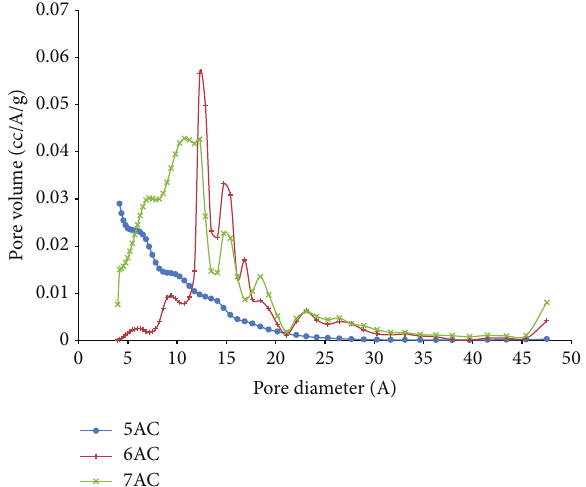
Figure 5: Results of PSD of palm shell activated carbon using DFT method.